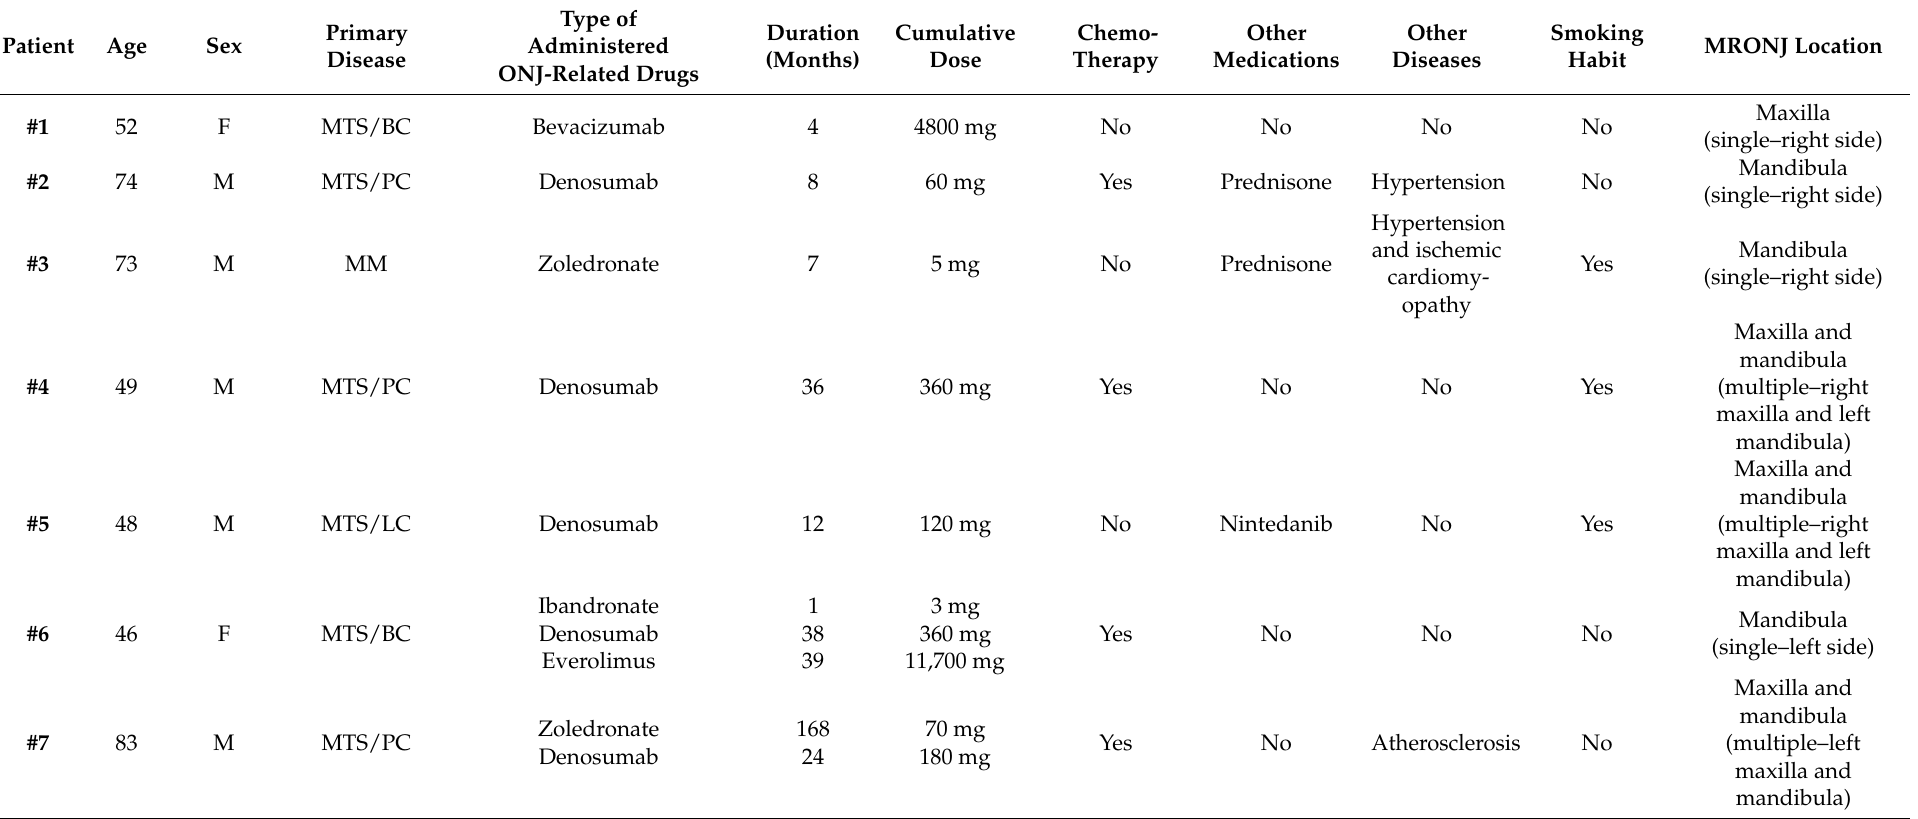
Table 2. Descriptive data of enrolled